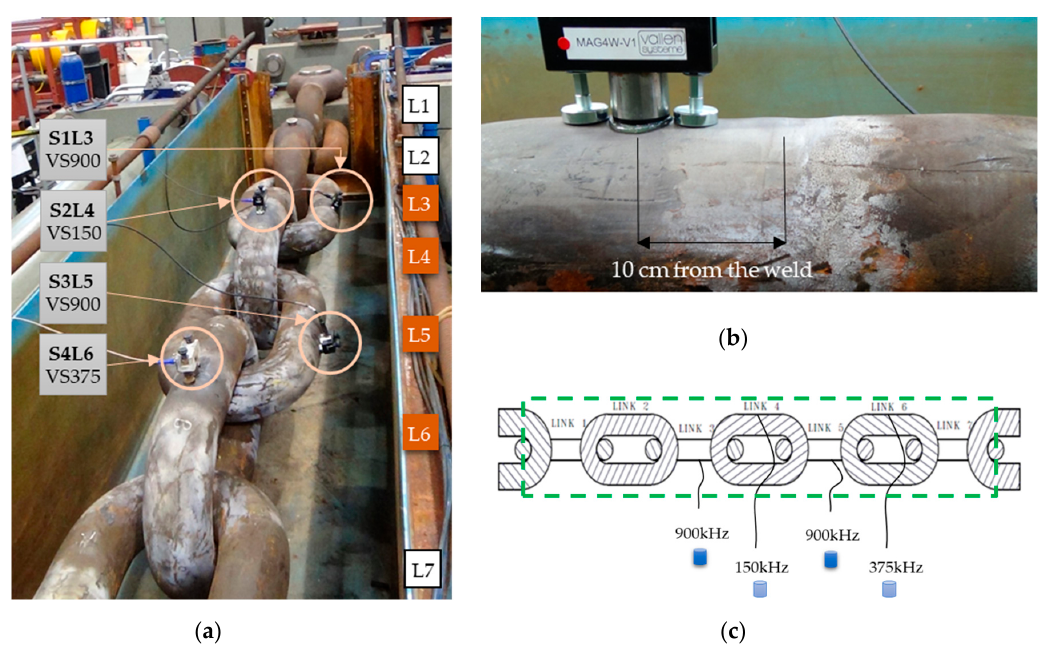
Figure 3. Sensor deployment on the chain in ( a ) the full-size test rig. Sensors fixed using magnetic holders 10 cm away from the link’s weld ( b ). Illustrative drawing of the chain ( c ).